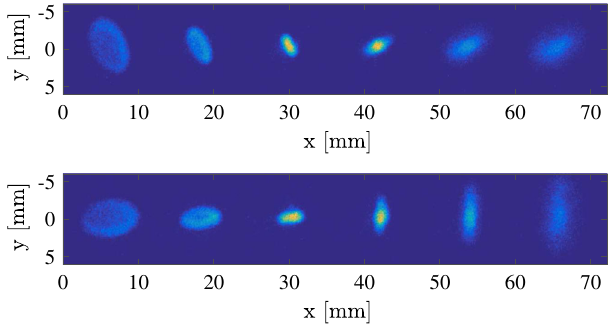
FIG. 8. Electron beam images on the YAG screen for different solenoid currents. The upper and lower rows correspond to ccw and cw solenoid current directions respectively.